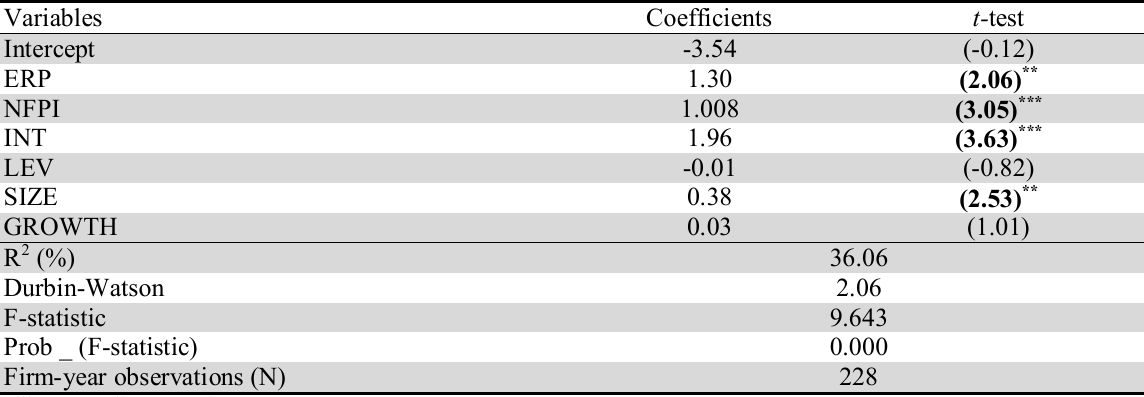
GLS regression model (Eq. (A.3)) with